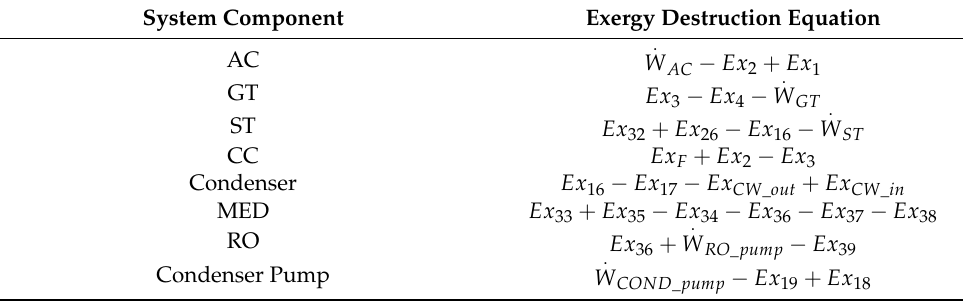
Table 4. Exergy destruction formulation for different system